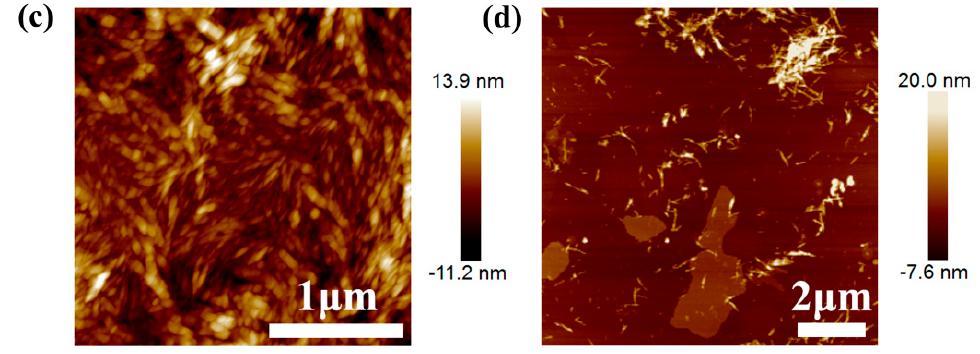
Figure 1. ( a ) AFM height image and cross-section profile of graphene sheets; AFM height images of ( b ) cellulose nanocrystals (CNC), ( c ) PCNC, and ( d ) graphene modified with PCNC.